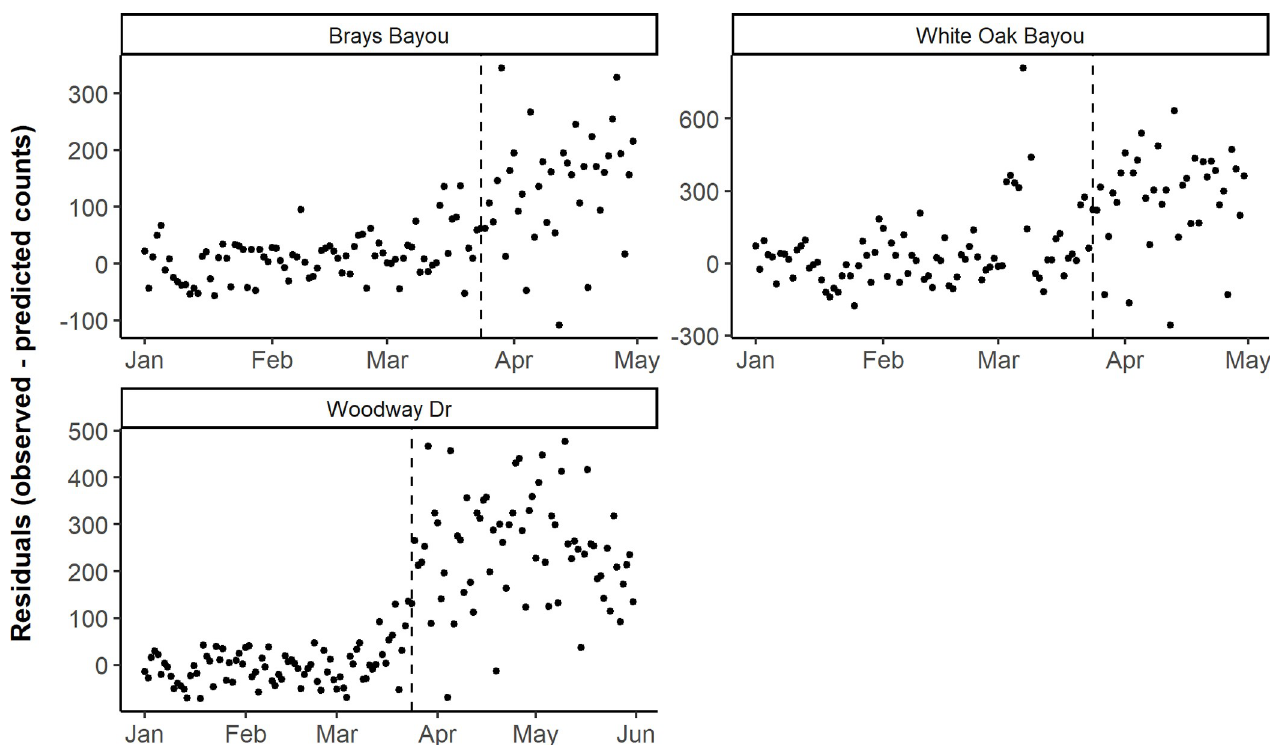
Fig 2. Daily observed minus predicted bicycle counts by counter location, before and during the Stay Home order in Houston. The vertical dashed line corresponds to the Stay Home order on March 24, 2020 in Harris County, Texas. Note the y-axis scales vary between plots to facilitate the interpretation of